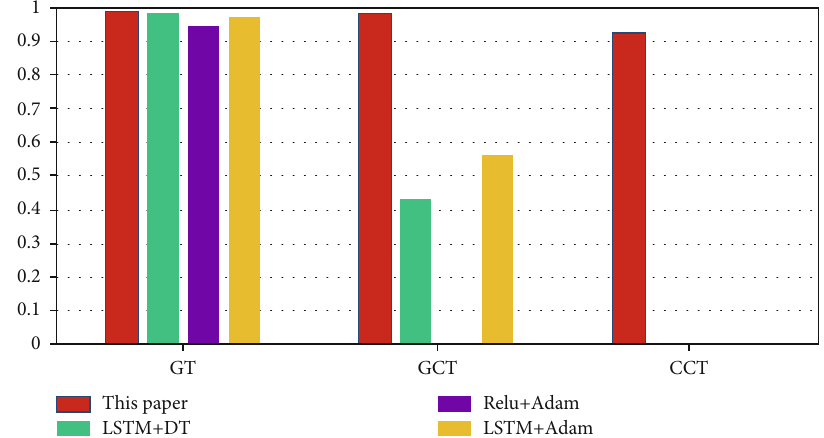
Figure 20: Recognition rate comparison. In the fi gure, GT represents general tactical intention, GCT represents general cooperative tactical intention, and CCT represents complex cooperative tactical